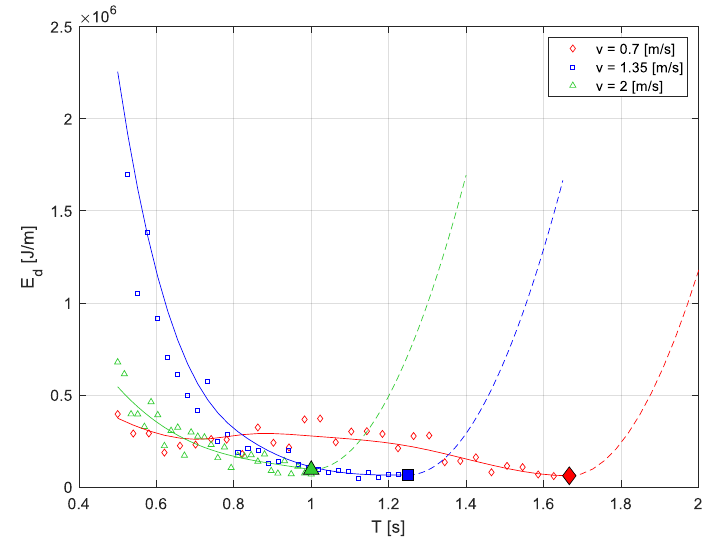
Figure 16. Walk gait energy 𝐸 𝑑 for different speeds and time cycles T.